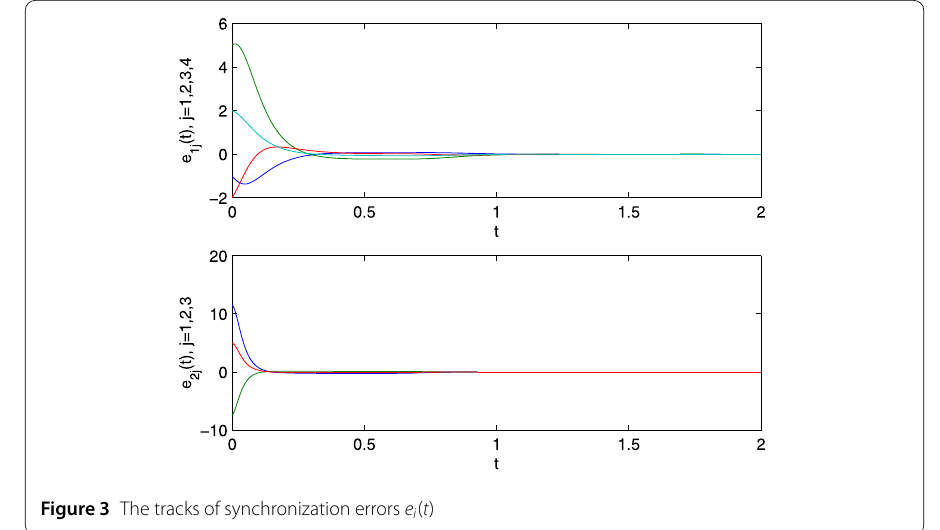
Figure 3 The tracks of synchronization errors e i ( t )